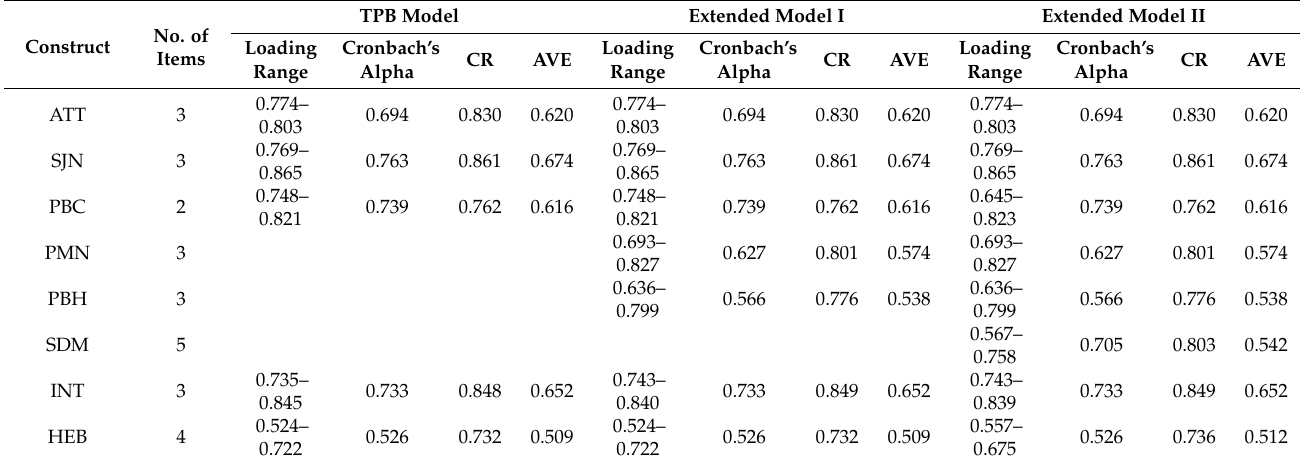
Table 2. Convergent validity results of the three models.